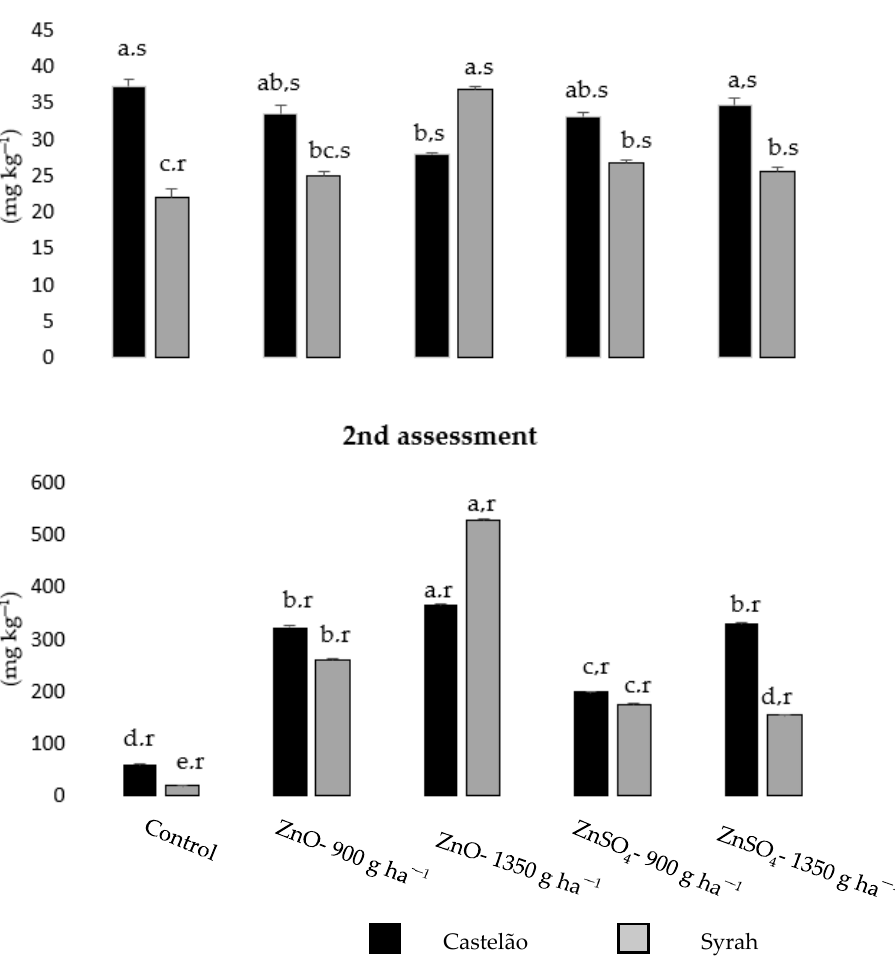
Figure 3. Average ± S.E. ( n = 3) of Zn concentration in leaves of Vitis vinifera, varieties Castelão and Syrah, without applications and after the 4th foliar application of ZnSO 4 or ZnO on 25 May (1st assessment) and 24 July 2019 (2nd assessment). Letters a, b, c, d, e indicate significant differences within the same column and variety, whereas letters r, s refer to significant differences in each variety between assessment dates for the same treatment (statistical analysis using the two-way ANOVA test, p < 0.05).